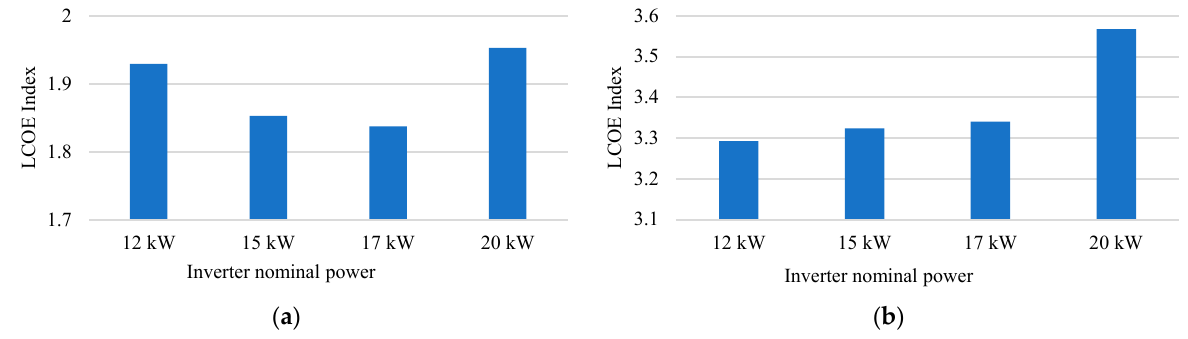
Figure 8. LCOE index for manufacturer C’s inverters at location: ( a ) Grenoble ( b ) Tehran computed from values extracted from datasheet.